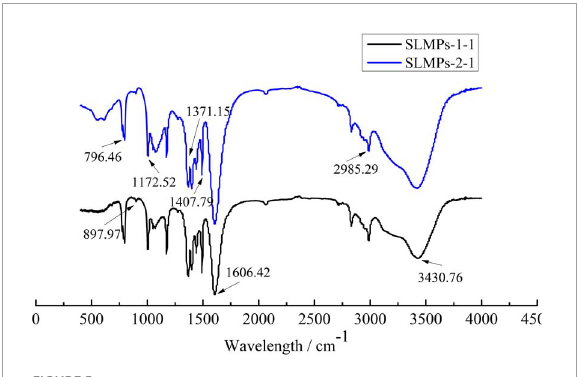
FIGURE5 Infrared spectra of SLMPs-1-1 and SLMPs-2-1.